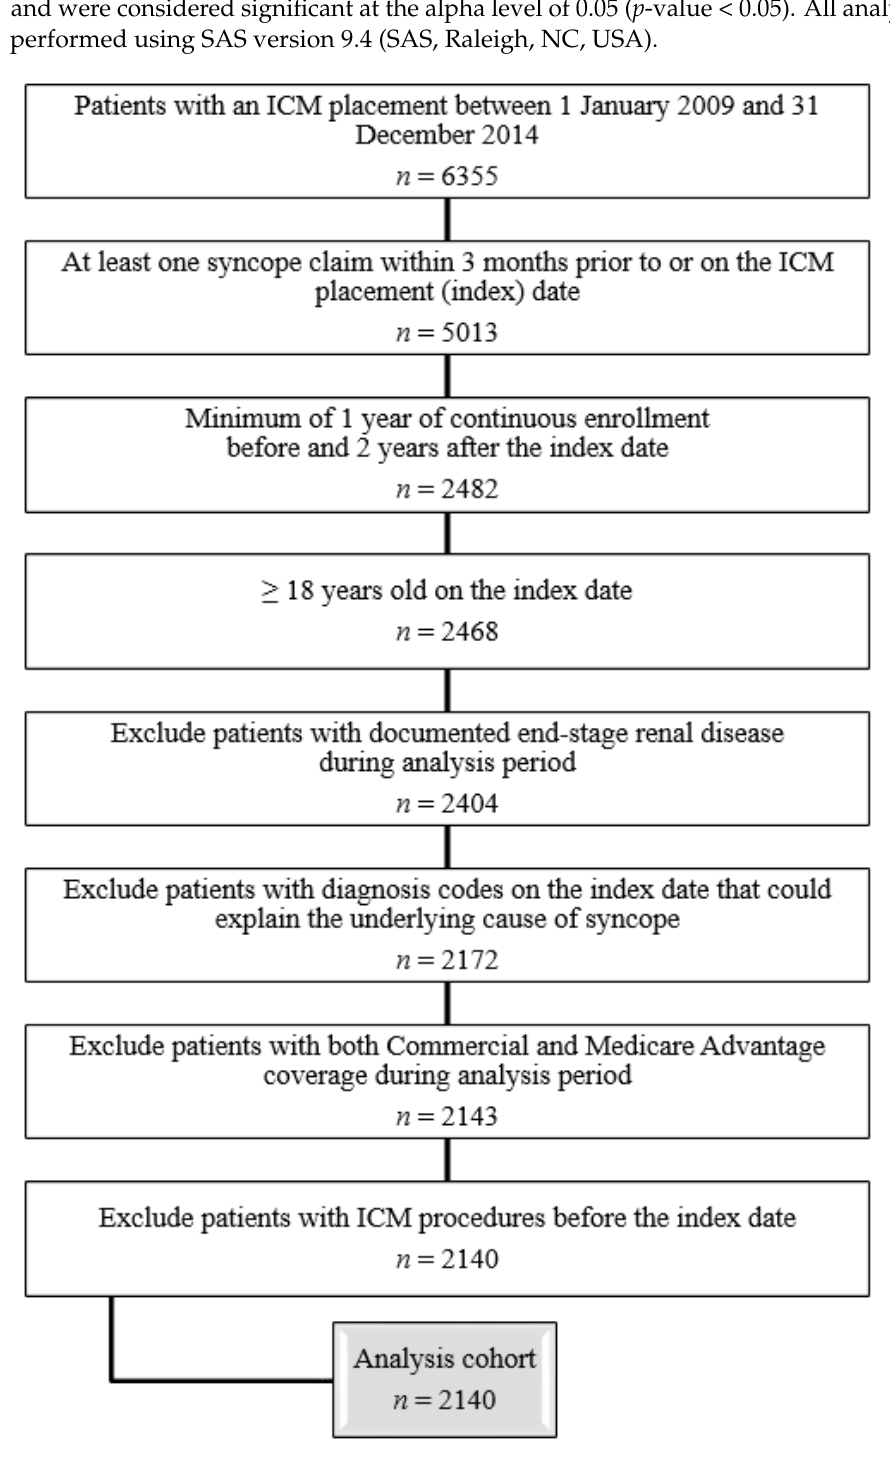
Figure 1. Consort diagram. Abbreviation: ICM: Insertable cardiac monitor.